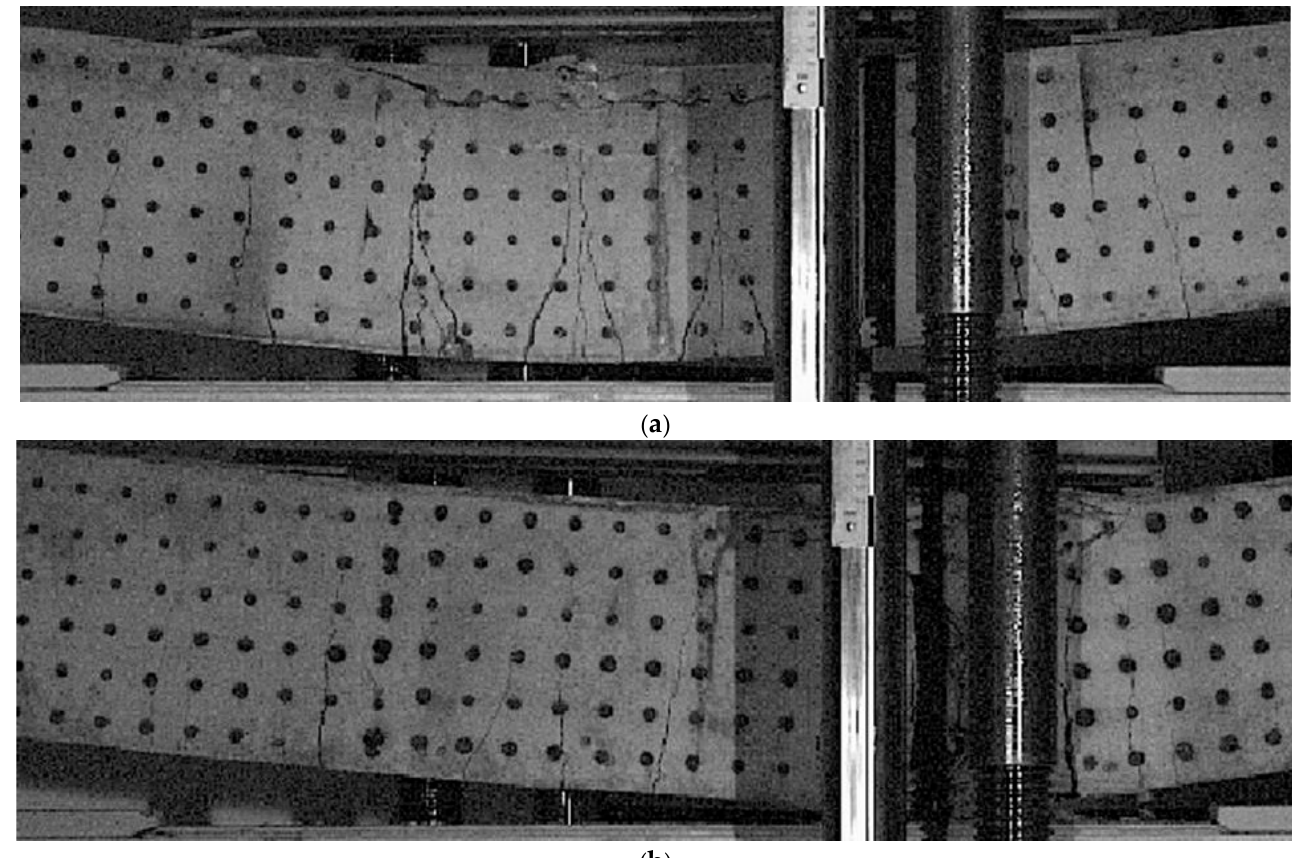
Figure 8. Zoomed view of the final cracking pattern for beams of Series 1: ( a ) beam C-s1 for c6(Q = 13.520 kN, v A = 128.6 mm), ( b ) beam T-s1 for t6(Q = 9.673 kN, v A = 139.2 mm).